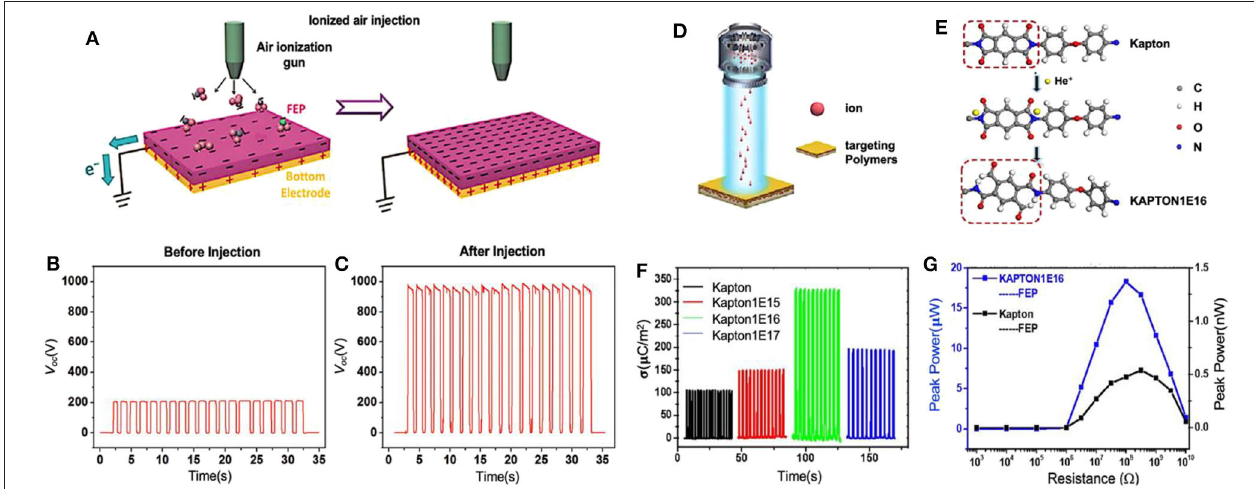
FIGURE 5 | Basic modification processes and output enhancement of triboelectric materials surfaces via ion injection and ion irradiation. (A) Schematic diagram of the ionized ion injection applying onto FEP surface with air ionization gun. (B,C) Open-circuit voltage of TENGs based on FEP films (B) before and (C) after the ion injection process. Reprinted with permission from Wang et al. (2014). Copyright 2014 Wiley-VCH. (D) Schematic diagram of ion irradiation simulation. (E) Schematic diagram of chemical structure changes of Kapton. (F) Transferred charge density and (G) output power of different ion concentration irradiated Kapton contracting with fluorinated ethylene propylene (FEP) films. Reprinted with permission from Li et al. (2020). Copyright 2019 Royal Society of Chemistry.